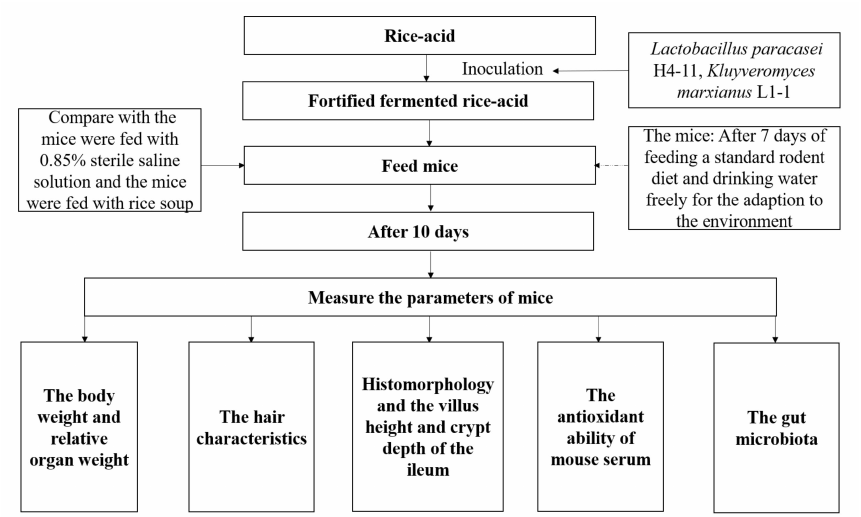
Figure 1. Schematic diagram indicating fortified fermented rice-acid, 0.85% sterile saline solution and rice soup intervention of the mice. Each group took the fortified fermented rice-acid, 0.85% sterile saline solution or rice soup for ten days,